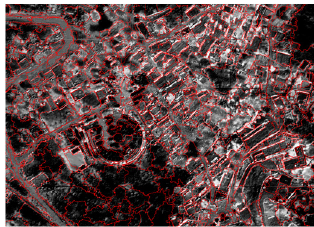
Figure 6. The probability overlay the boundary of segmentation spots